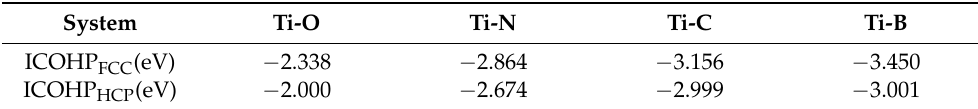
Table 2. Integral of crystal orbital Hamilton populations analysis.